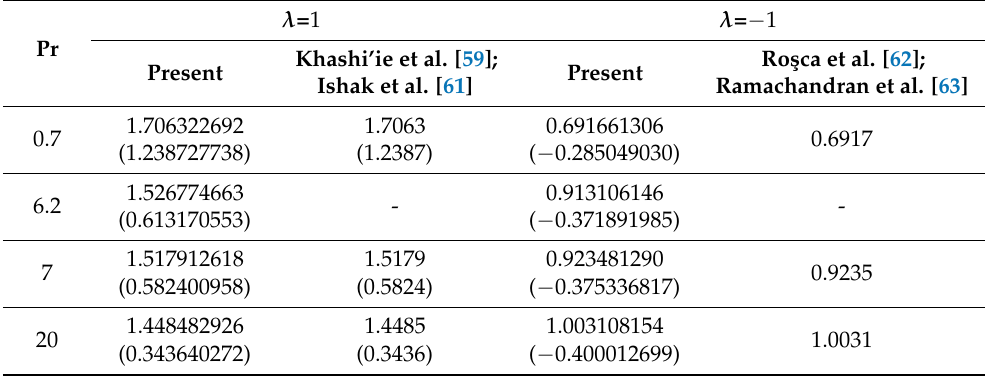
Table 3. Values of f (cid:48)(cid:48) ( 0 ) when N = Rd = Du = Sc = Sr = φ 1 = φ 2 = 0 and Bi → ∞ .